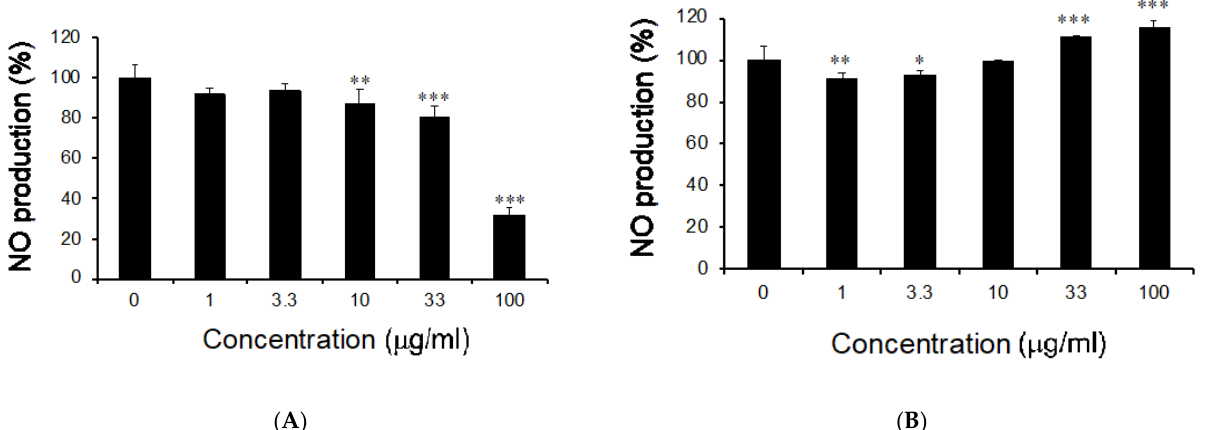
Figure 1. Inhibitory effects of Morinda citrifolia seeds extract or oil on NO production in LPS-stimulated RAW264 cells. Cells were treated with M. citrifolia ( A ) seed extract or ( B ) oil for 0.5 h before incubation with LPS (200 ng/mL). The indicated concentration shows the final concentration of the test samples incubated with LPS for 24 h. The level of NO in the culture medium was measured using the Griess reaction. Data are presented as mean ± standard deviation (SD) ( n = 4). * p < 0.05, ** p < 0.01, *** p < 0.001 compared to the sample with 0 (zero) concentration.